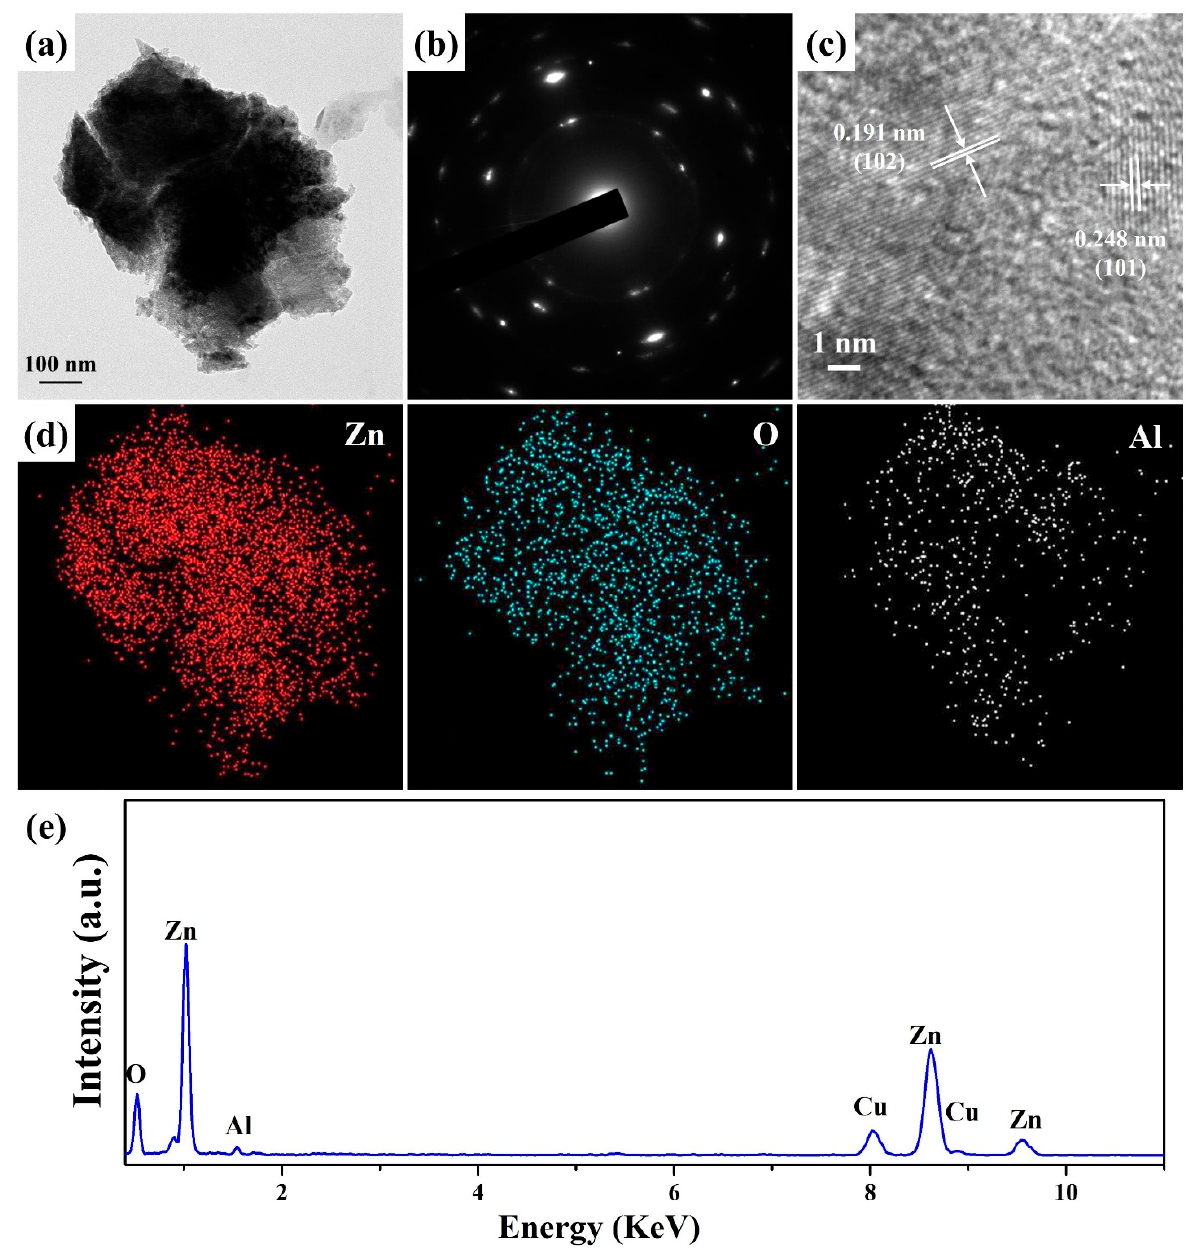
Figure 6. ( a ) FETEM, ( b ) SAED pattern, ( c ) HRTEM, ( d ) EDS mapping images, and ( e ) EDS spectrum of a ZnO nanowall (50 mM).